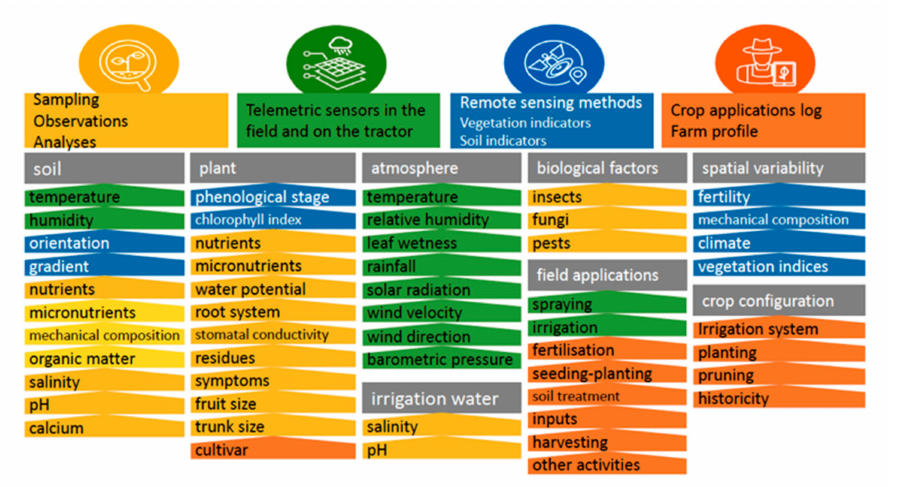
Figure 1. Information sources and measured data types towards the realization of smart